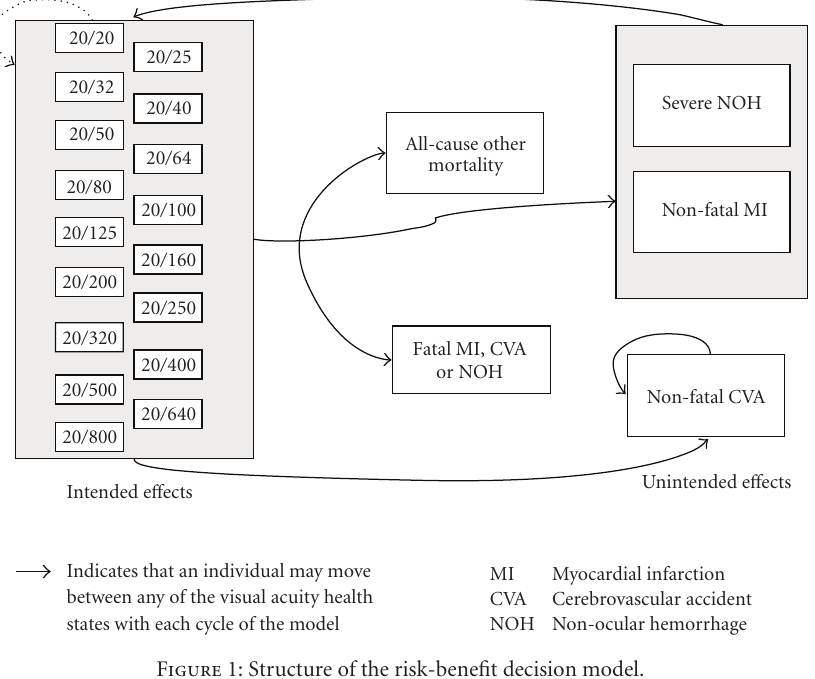
Figure 1: Structure of the risk-benefit decision